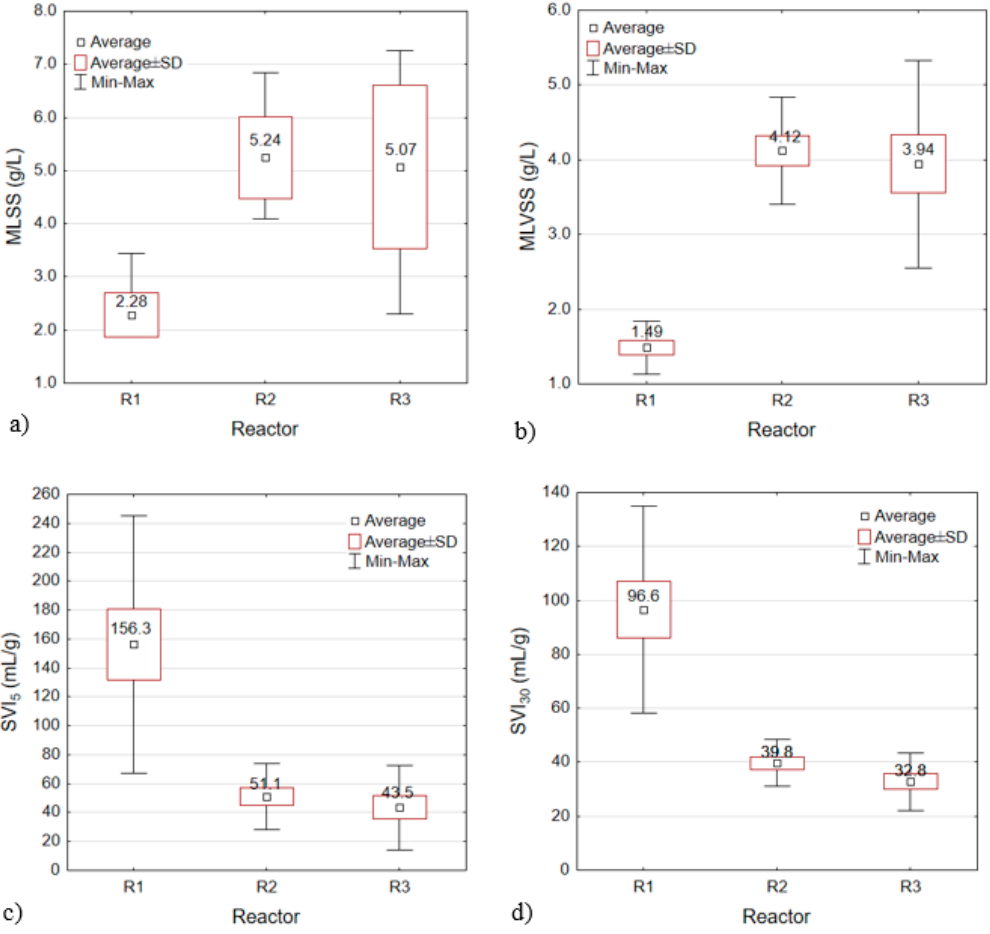
Figure 2. Average MLSS ( a ), MLVSS ( b ), SVI 5 ( c ), and SVI 30 ( d ) values of reactors.